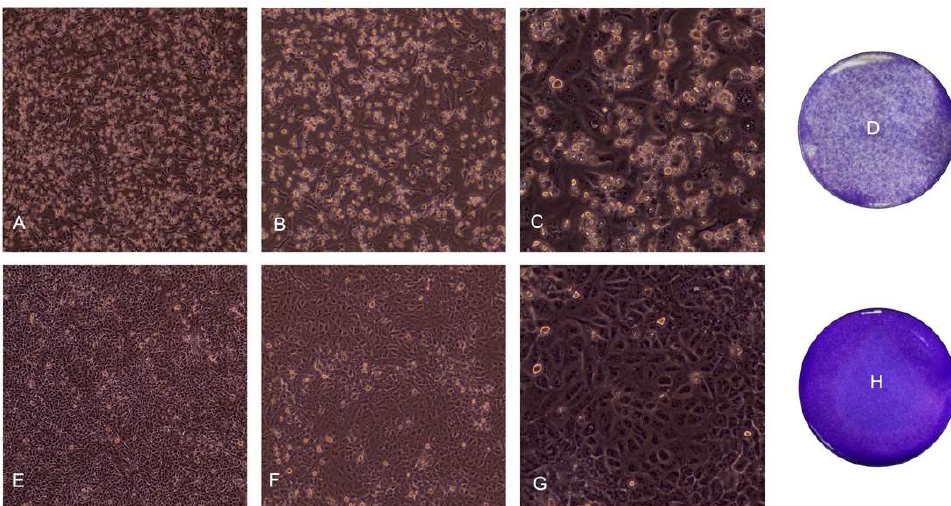
Figure 1. Representative images of the cytopathic effect induced by SARS-CoV-2 infection at the 7th day. Non-treated cells are shown for comparison. 10 × , 20 × , and 40 × magnification are displayed. ( A ) Cytopathic effect induced in infected cells, 10 × ; ( B ) Cytopathic effect induced in infected cells, 20 × ; ( C ) Cytopathic effect induced in infected cells, 40 × ( D ) Cytopathic effect induced in infected cells, crystal violet staining; ( E ) Non-treated cells, 10 × ; ( F ) Not treated cells, 20 × ; ( G ) Not treated cells, 40 × ; ( H ) Not treated cells, crystal violet staining.